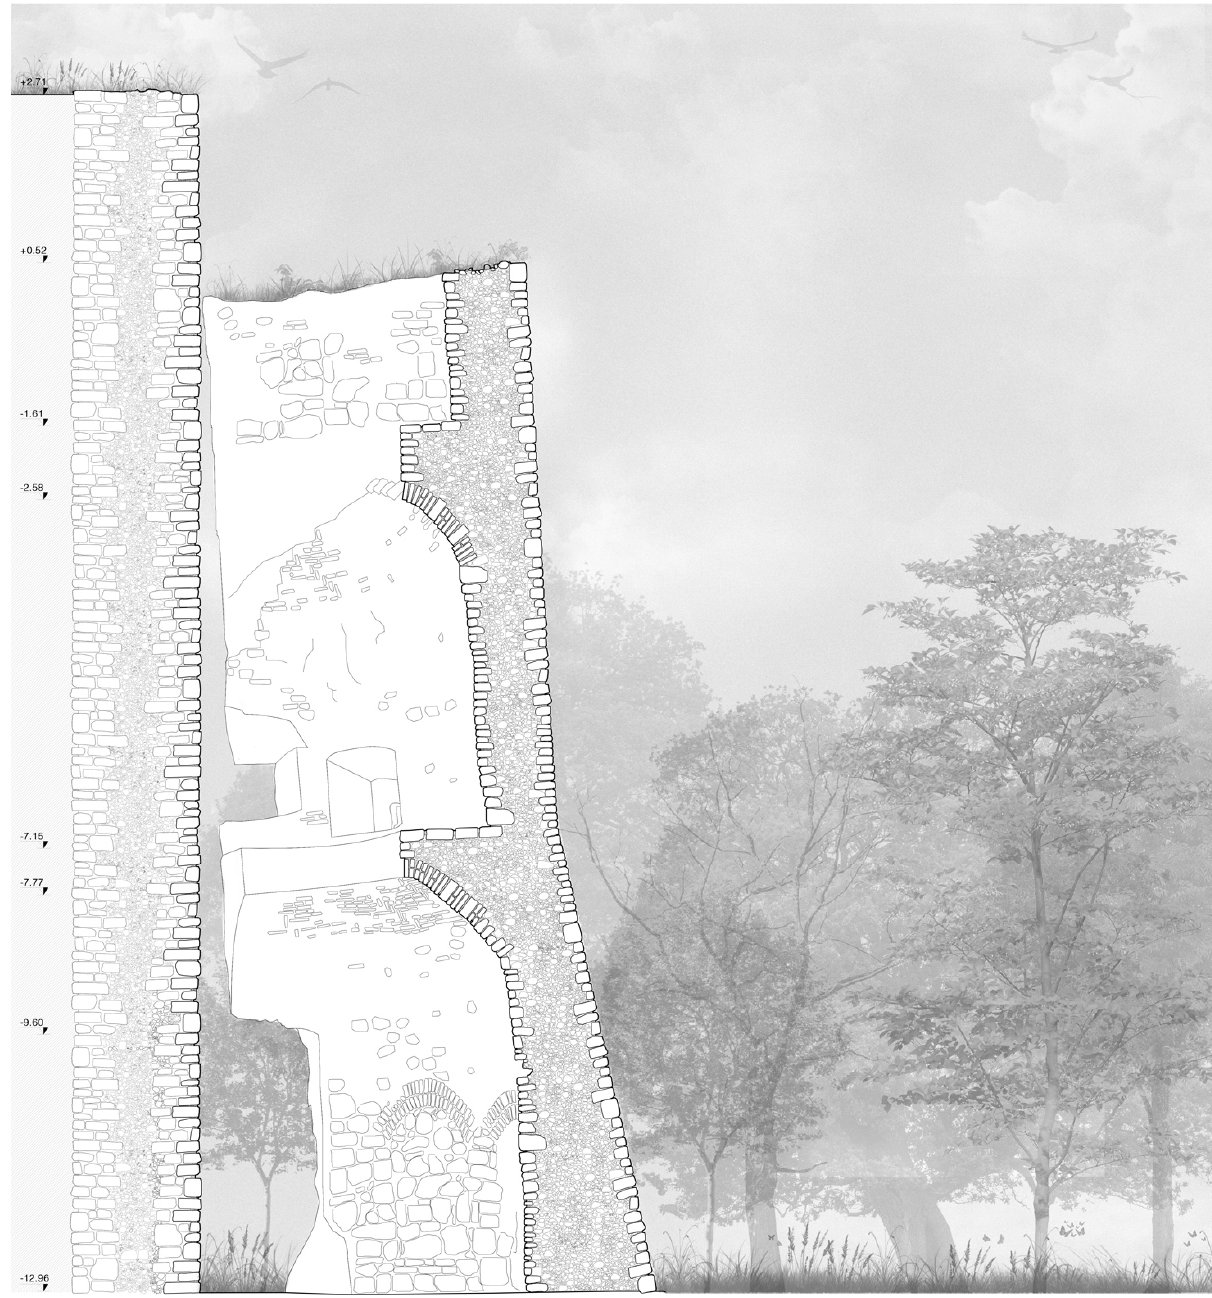
Figure 4. Castrocaro, section tower NE (surveyors S. Iosca, E.